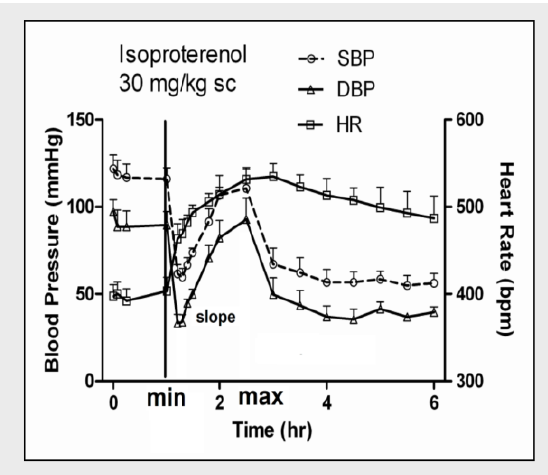
Figure 2. Hemodynamic effect before and after isoproterenol injection (30 mg/kg) in rats. Each point represents mean ± SEM.